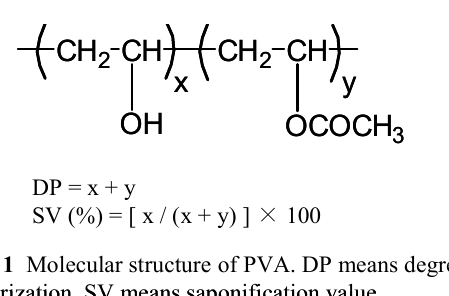
Figure 1 Molecular structure of PVA. DP means degree of polymerization, SV means saponification value.